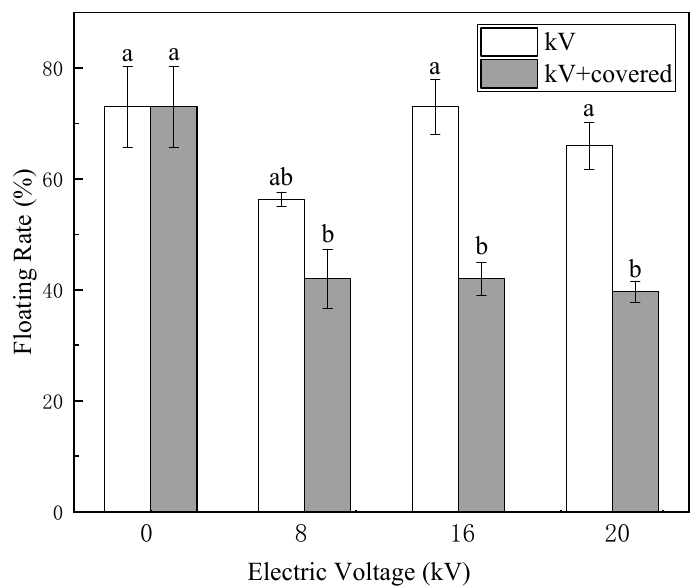
Figure 4. Changes in the floating rate of naked oat seeds after HVEF treatment (Different letters indicate statistically significant differences between treatments ( p < 0.05)).